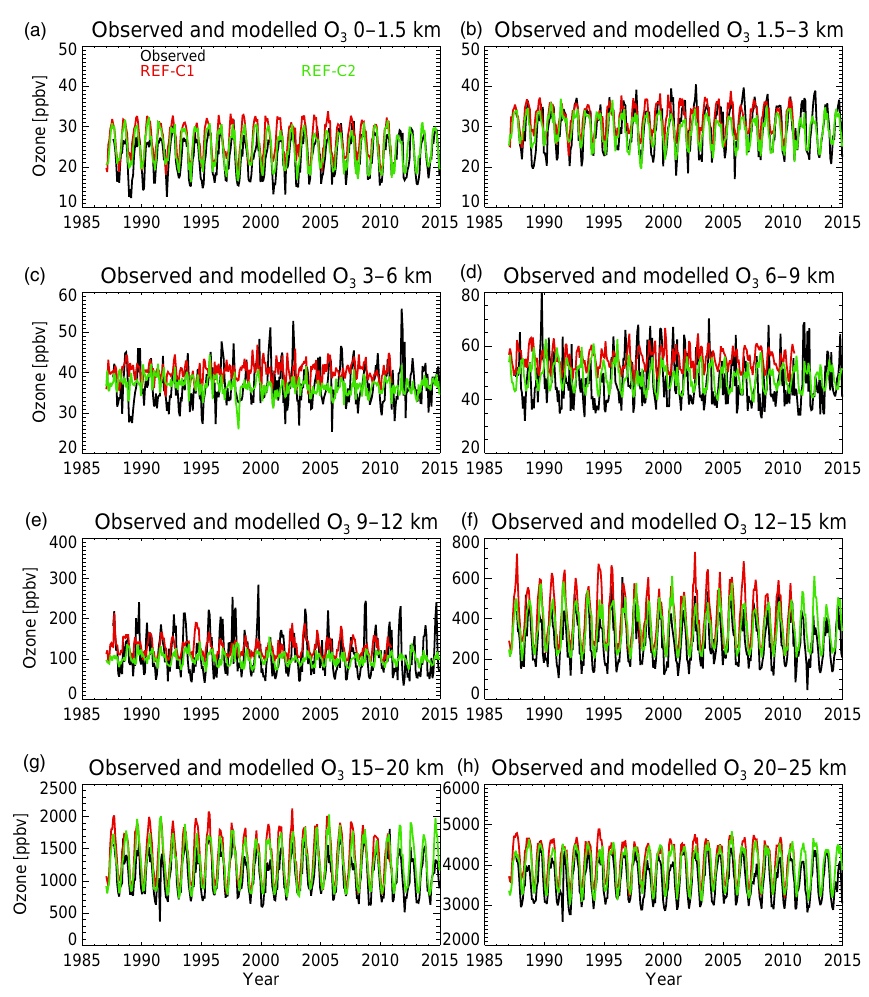
Figure 6. Observed (black) and modelled monthly mean O 3 time series, from REF-C1 (red) and REF-C2 (green), respectively, at Lauder over 1987–2014. The REF-C1 simulation ends in year